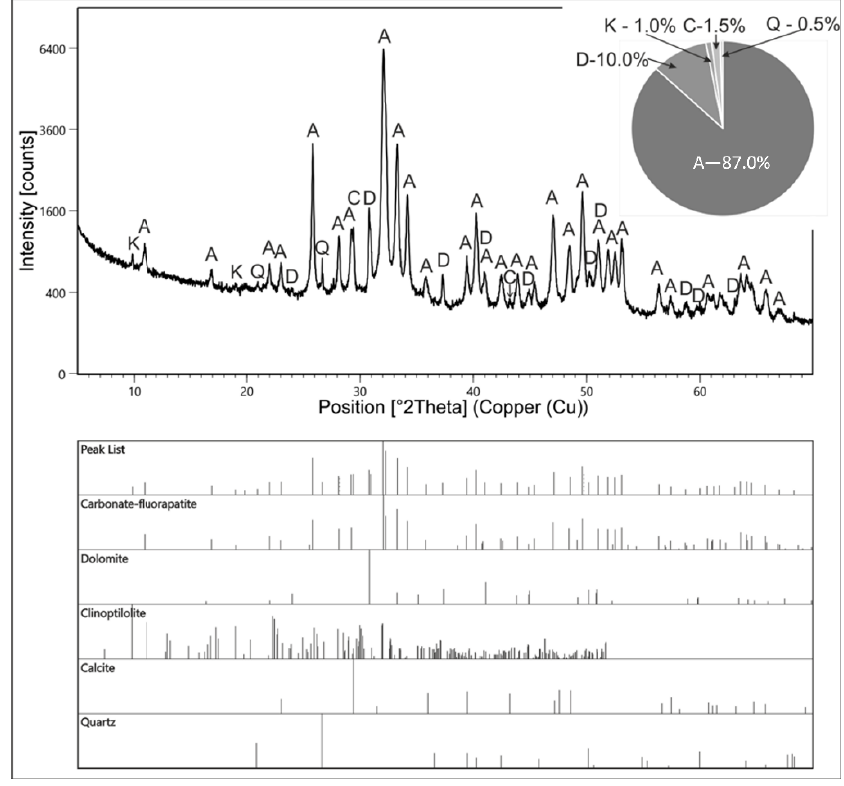
Figure 2. XRD pattern of a Djebel Onk sample after mechanical preparation (fraction 80 –160 μm), with the results of qualitative analysis (table showing the matched patterns) and semi-quantitative calculations (pie chart, all values are weight). Mineral symbols: A — apatite, C — calcite, D — dolomite, K — clinoptilolite, Q — quartz.